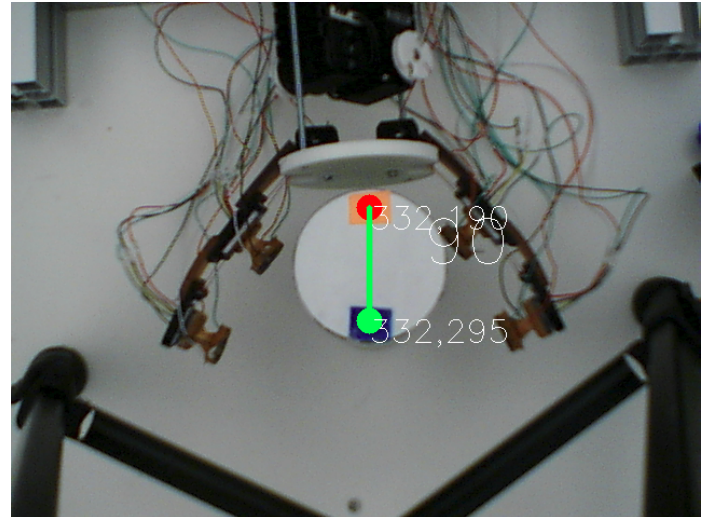
Figure 13. Angle measured from the center of color blobs in the diameter of the